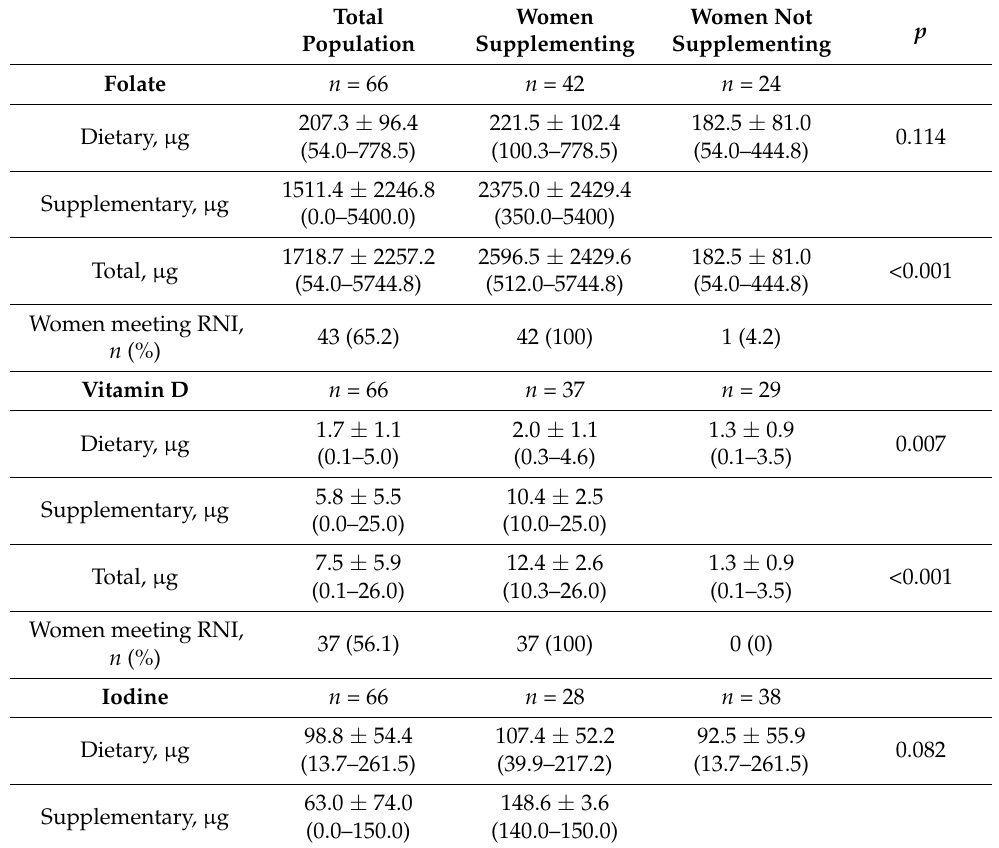
Table 2. Trimester 1 intakes of folate, vitamin D and